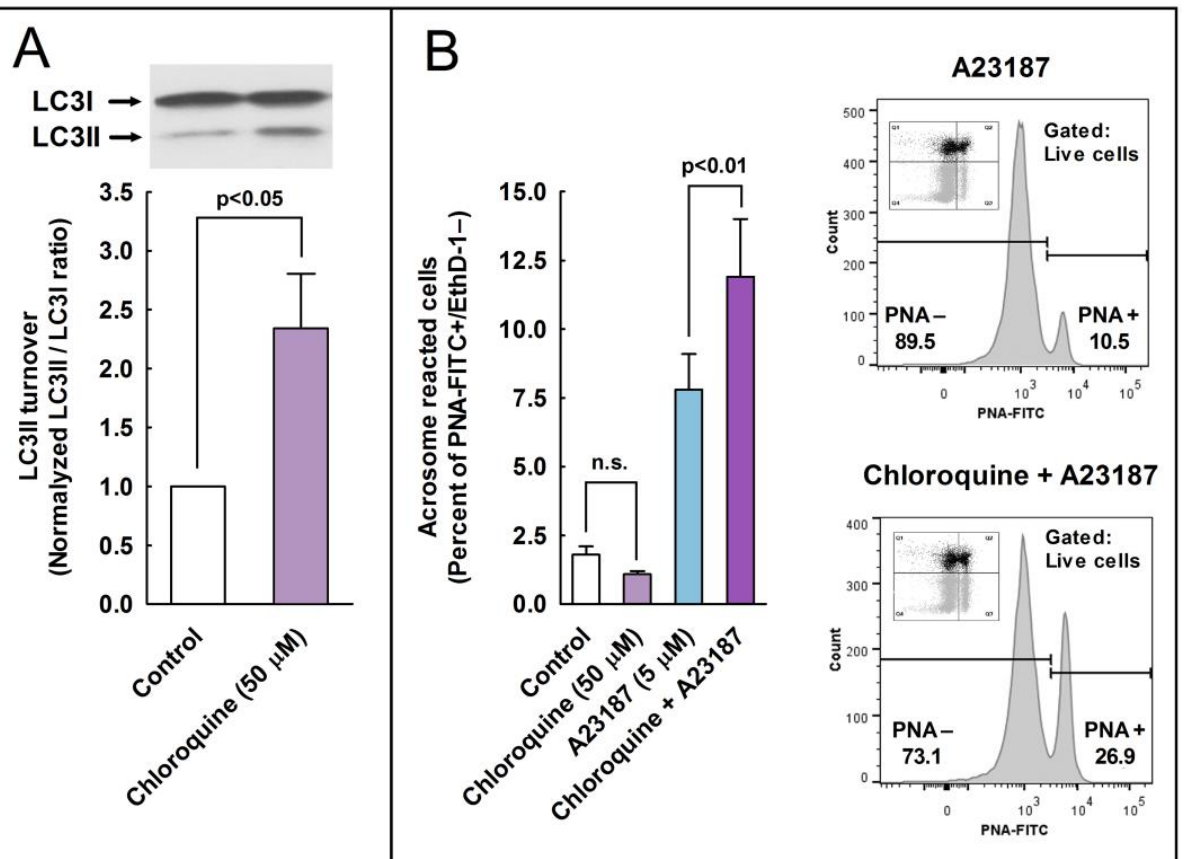
Figure 8. Effect of the autophagy inhibitor chloroquine on the processing of LC3II and the develop- ment of the acrosome reaction in stallion sperm cells. ( A ) Stallion spermatozoa were incubated for 3 h in BWW at 37 °C in the presence or absence of chloroquine (50 µM). After incubation, the pro- cessing of LC3I to LC3II was assessed by western blotting. LC3 turnover was expressed as the nor- malized LC3II/LC3I ratio (control samples always equal 1). Values represent the mean ± SEM of 4 independent experiments. A two- tailed Student’s t -test for unpaired samples was applied to com- pare the means of each group with the significance level set at 0.05, as is indicated in the figure. In the top of the panel, there is a representative immunoblotting of three other independent experi- ments. ( B ) Stallion spermatozoa were incubated for 150 min in BWW at 37 °C in the presence or absence (Control) of chloroquine (50 µM) and then were further incubated with 5 µM A23187 or the vehicle for 30 min (final incubation time 180 min). After incubation, spermatozoa were washed with PBS and labeled with probes to characterize, by flow cytometry, the DNA content (Hoechst 33342), cellular viability (EthD-1), and acrosome reaction (PNA-FITC). Cytometry data were processed as above, performing the analysis by quadrants (graph) or after gating out dead cells (histograms on the right). Results in the graph represent the mean ± SEM of 4 independent experiments expressed as the percentage of acrosome-reacted live sperm cells (Q3 quadrant). A two- tailed Student’s t -test for unpaired samples was applied to compare the mean of each treatment with their respective con- trols. The significance level is indicated in the figure.